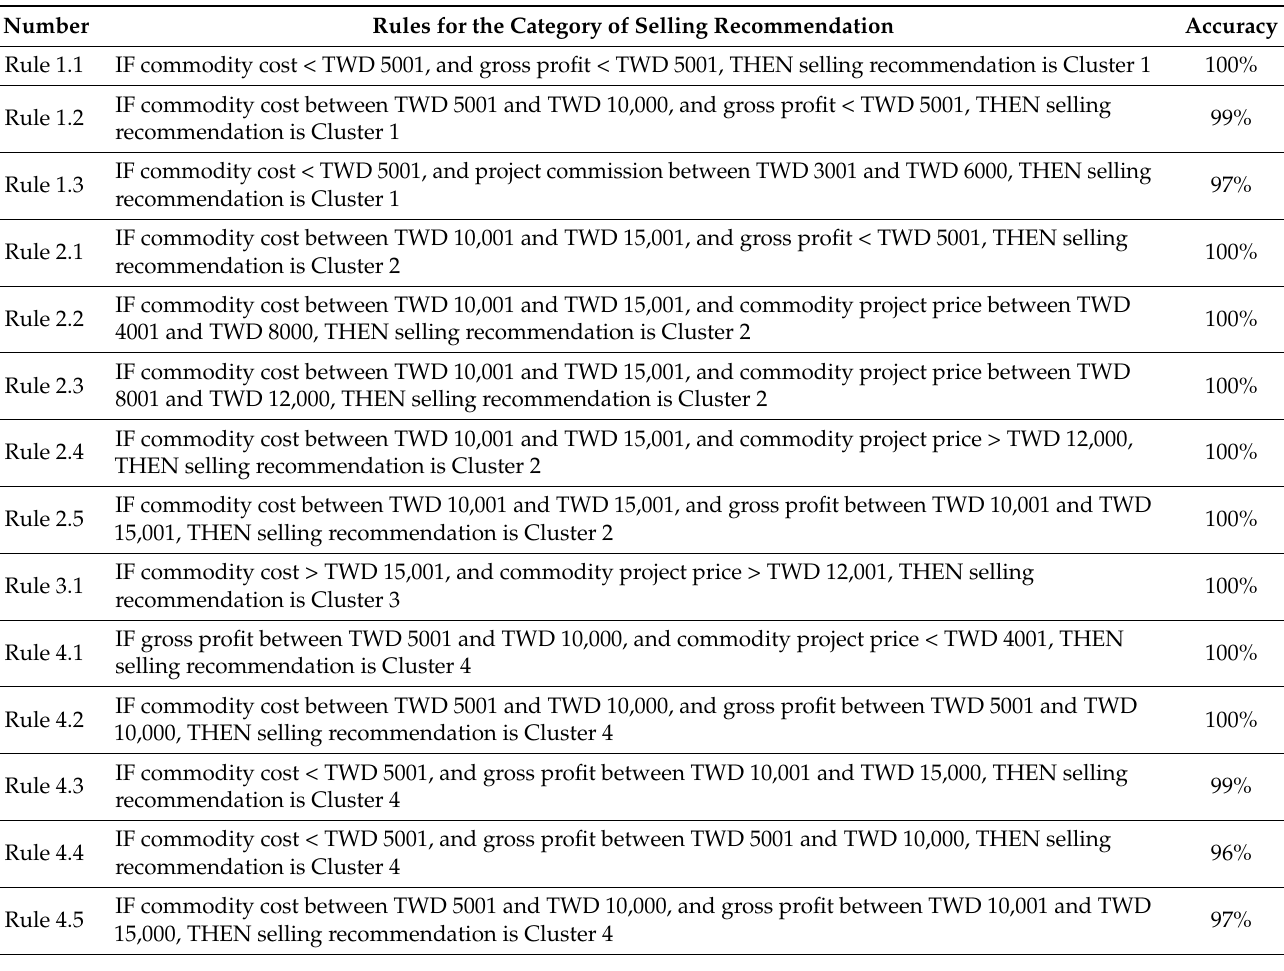
Table 3. Rules obtained by using C5.0 decision tree